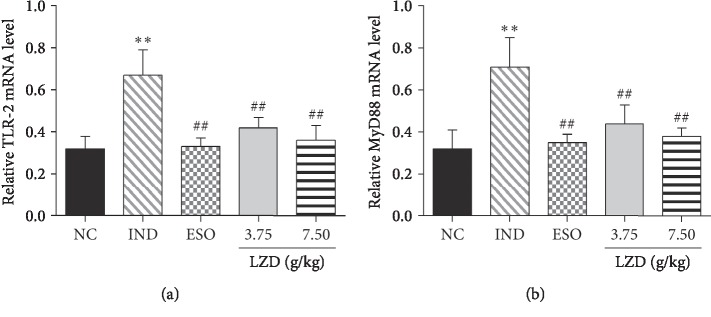
Effects of LZD on levels of TLR-2 (a) and MyD88 (b) mRNA expression during prevention of IND‐induced duodenal ulceration. Levels of TLR-2 and MyD88 mRNA were determined by qRT-PCR assay. β-Actin mRNA was used as internal control for equal loading. Results are expressed as mean ± SEM, n = 3. Asterisks and pound signs indicate significant differences: ∗∗P < 0.01 versus normal control (NC); ##P < 0.01 versus negative control (IND).